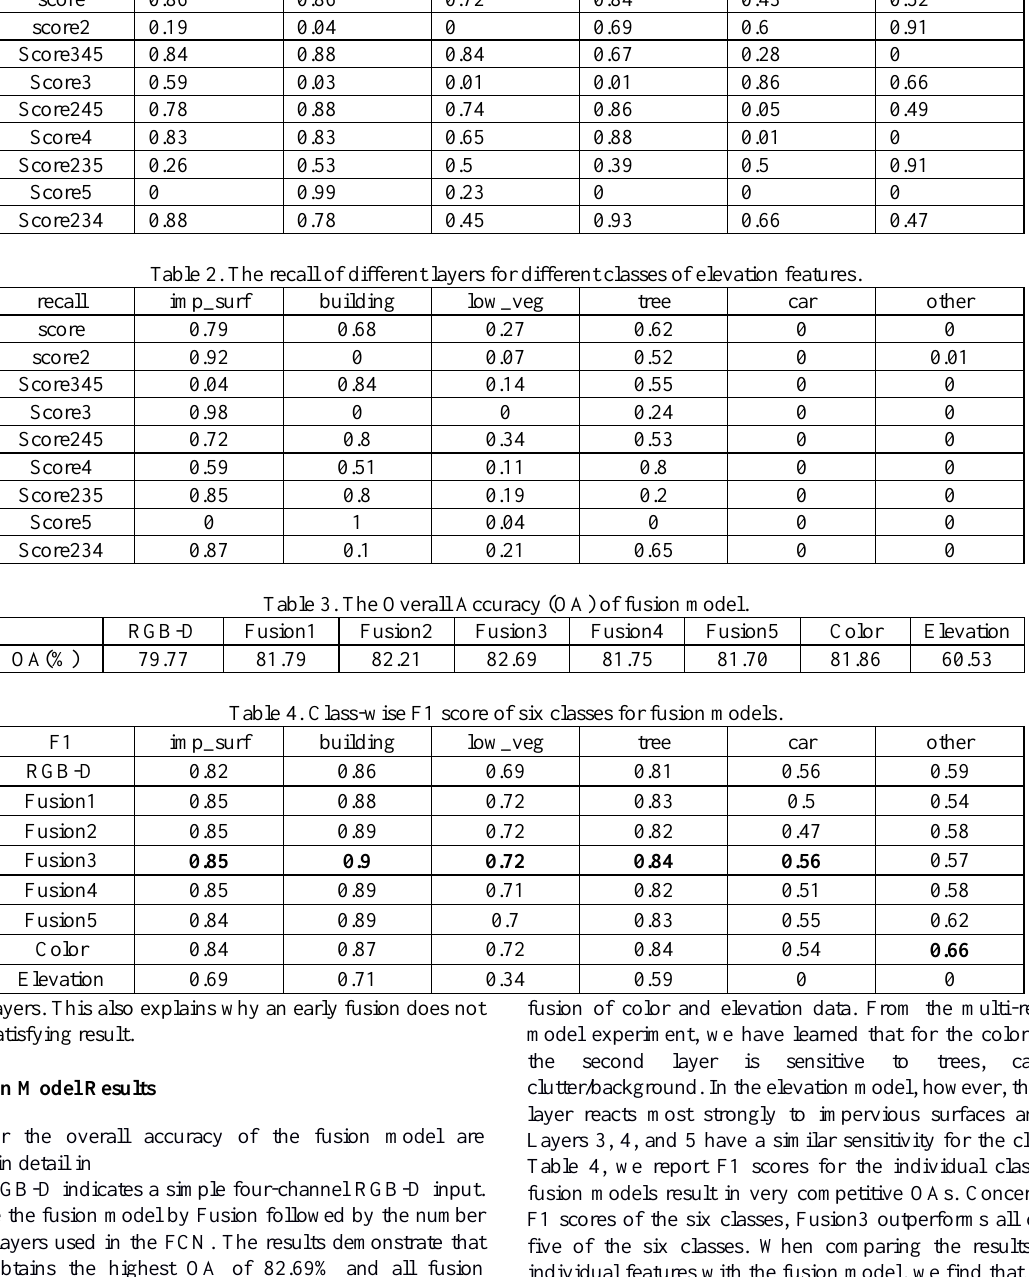
Table 3. RGB-D indicates a simple four-channel RGB-D